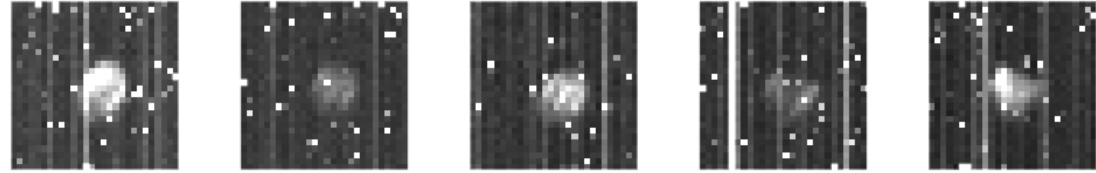
Figure 1. Examples of windows extracted around the observed stars. The intensities in the figure were scaled to better expose the problems of DC background. The images were registered by the BAb satellite with 1 s exposure